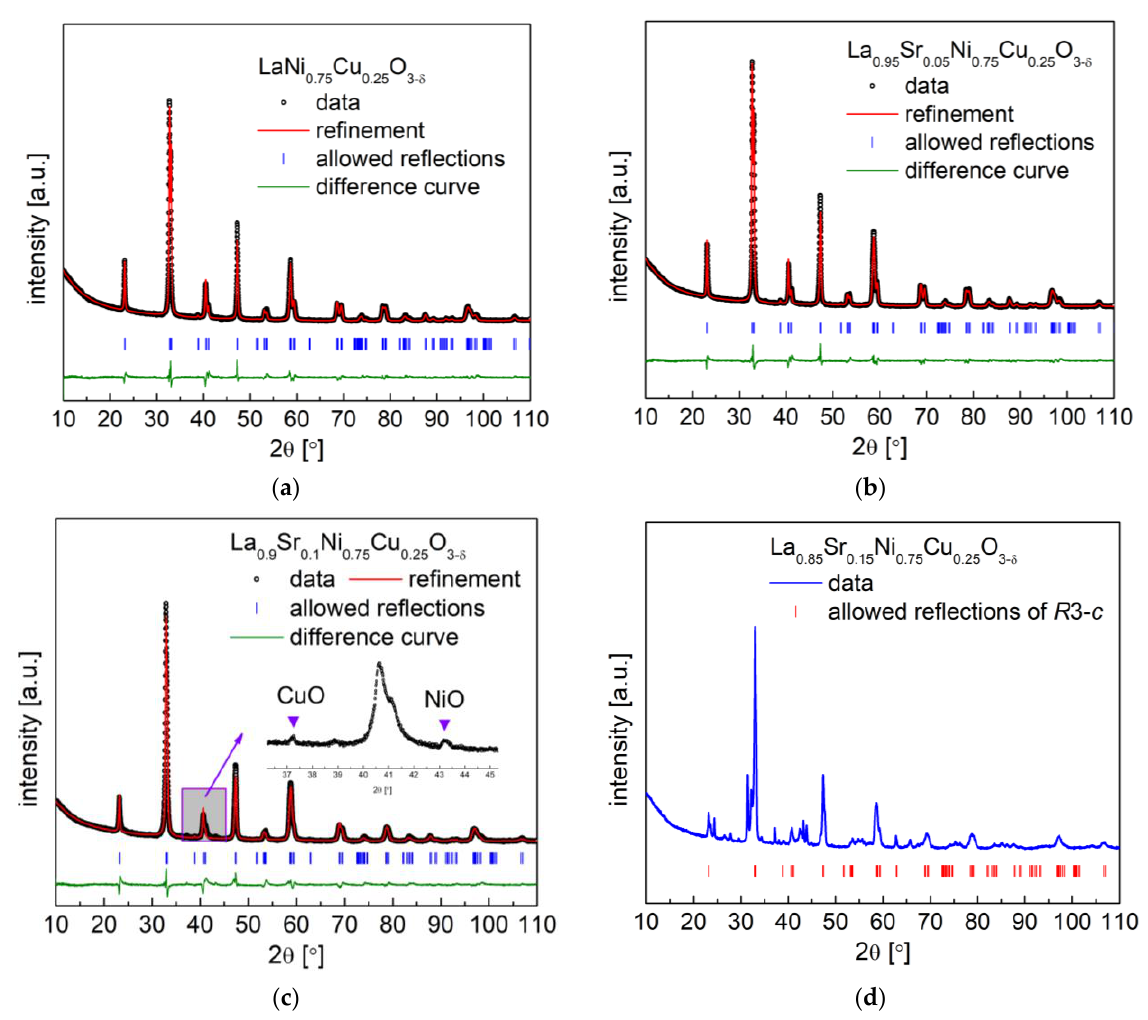
Figure 1. XRD patterns with Rietveld refinement recorded for La 1−x Sr x Ni 0.75 Cu 0.25 O 3−δ oxides with ( a ) x = 0; ( b ) x = 0.05; ( c ) x = 0.1; ( d ) XRD patterns of La 0.85 Sr 0.15 Ni 0.75 Cu 0.25 O 3−δ oxides.